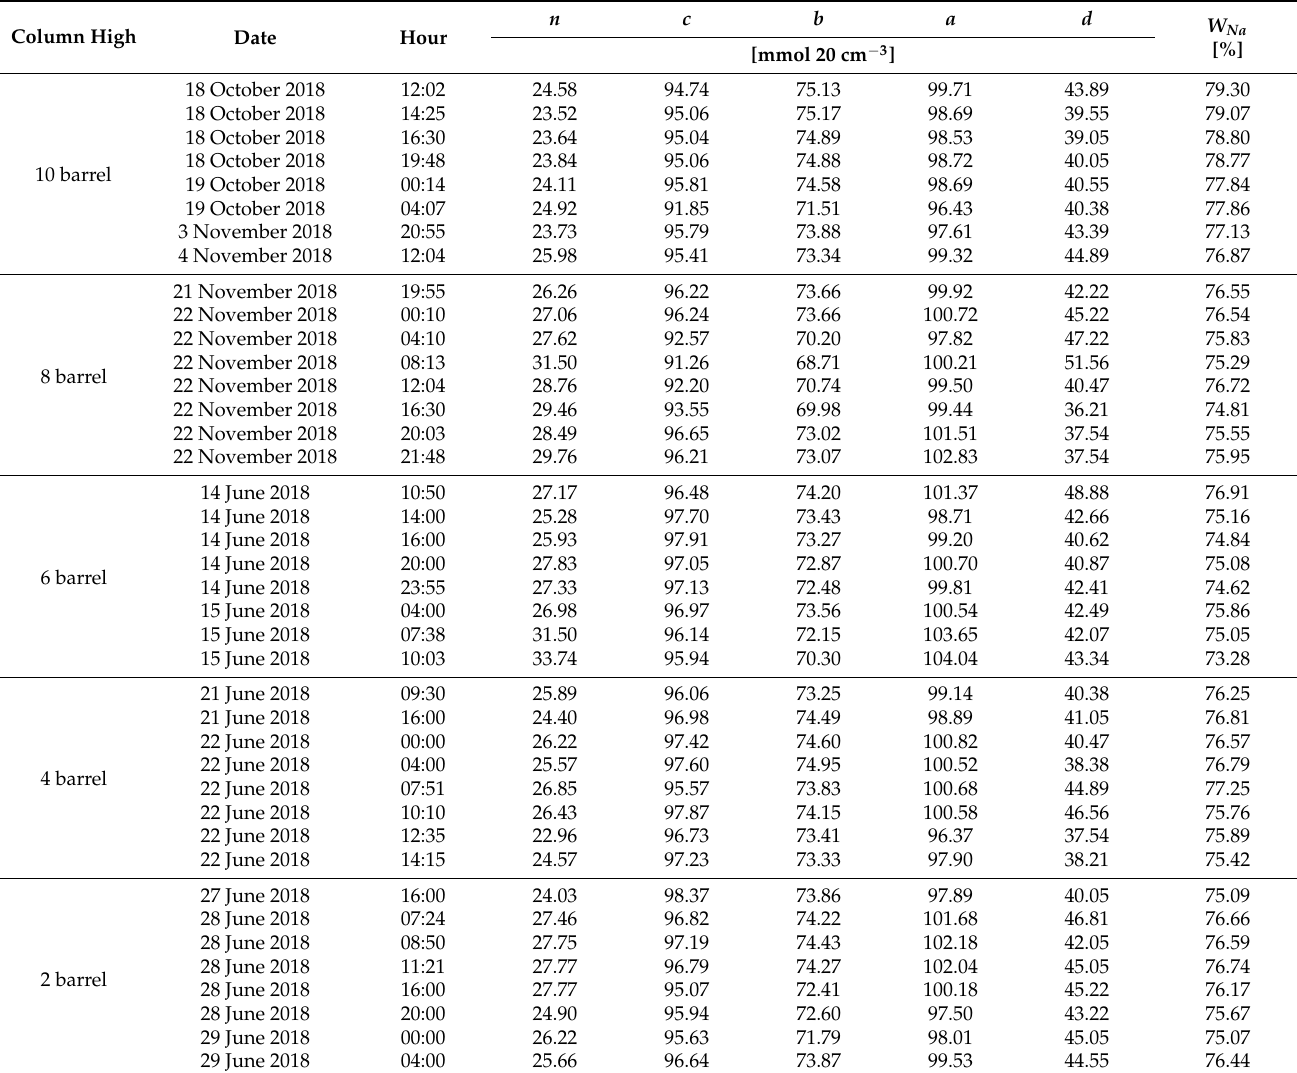
Table 1. Selected results of dosing an additional stream of ammonia to the selected place of the